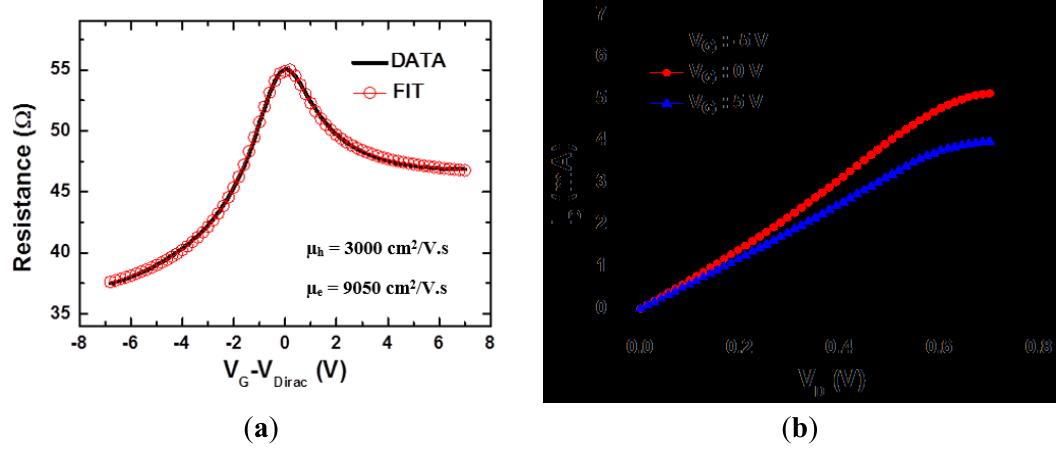
Figure 3. Electrical properties of graphene transistor ( a ) Gate modulation of graphene resistance. The drain voltage is set to 10 mV; ( b ) Drain current (I D ) vs. Drain voltage (V D